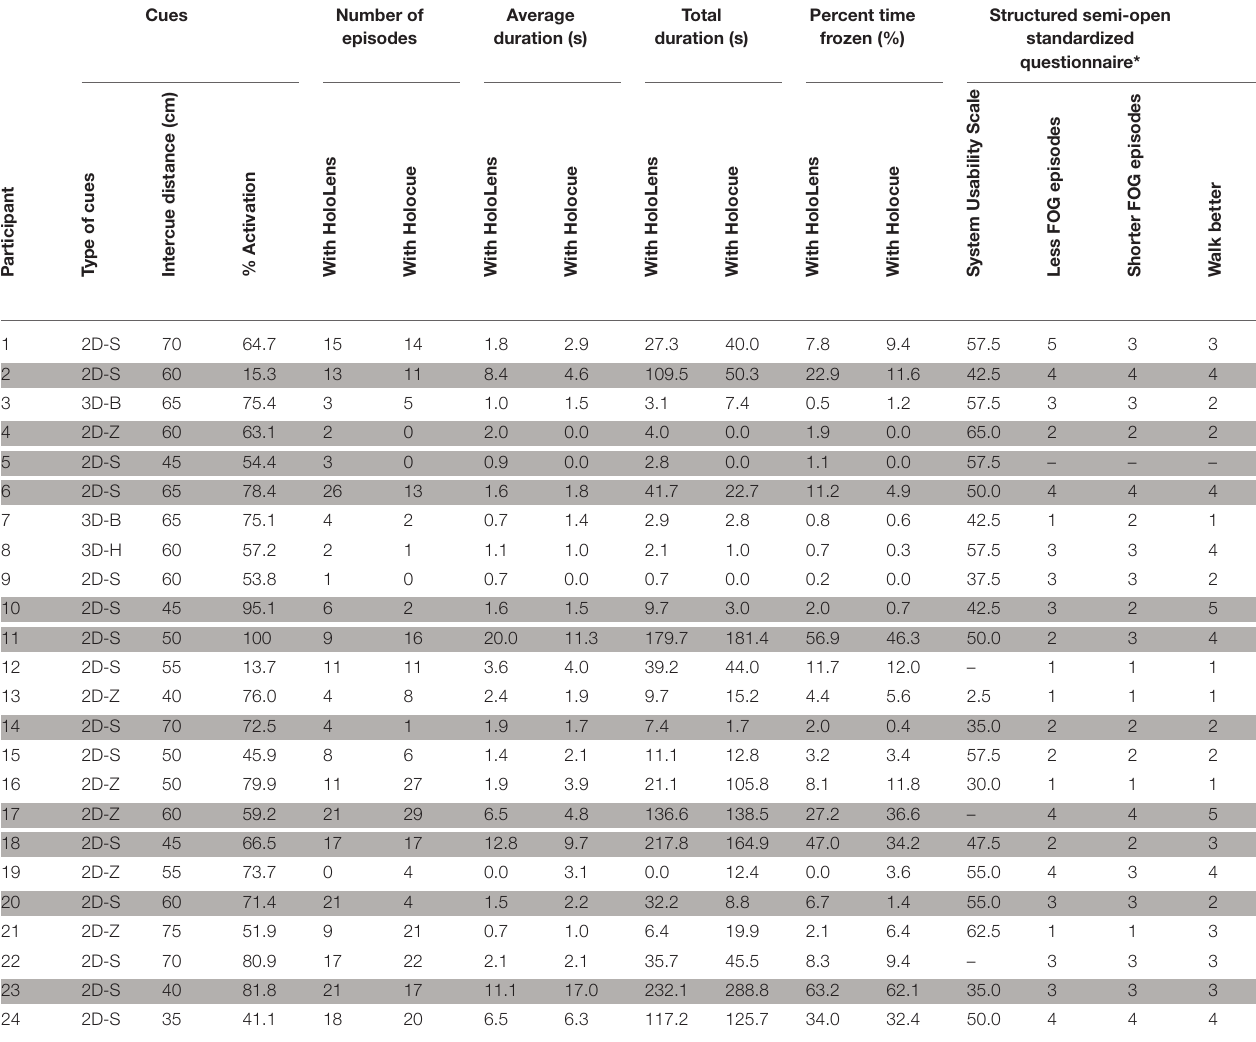
TABLE 1 | Individual results of the settings of the cues, the immediate effect of Holocue on FOG, and answers to some questions from the structured semi-open standardized questionnaire from Session 3. Cues Number of Average Total Percent time Structured semi-open episodes duration (s) duration (s) frozen (%) standardized